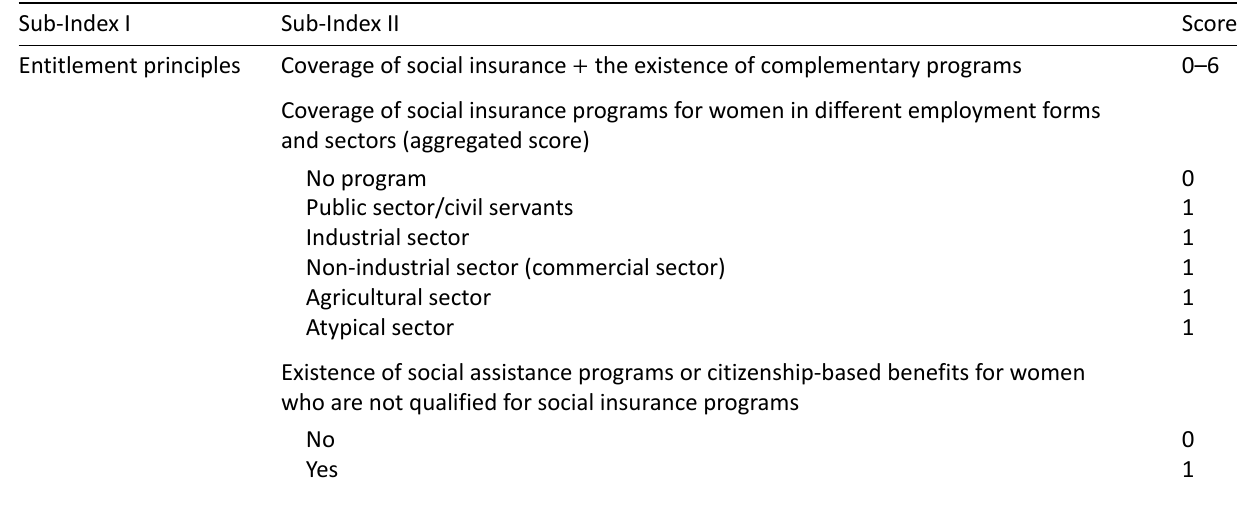
Table 1. Operationalization of index of inclusiveness of maternity